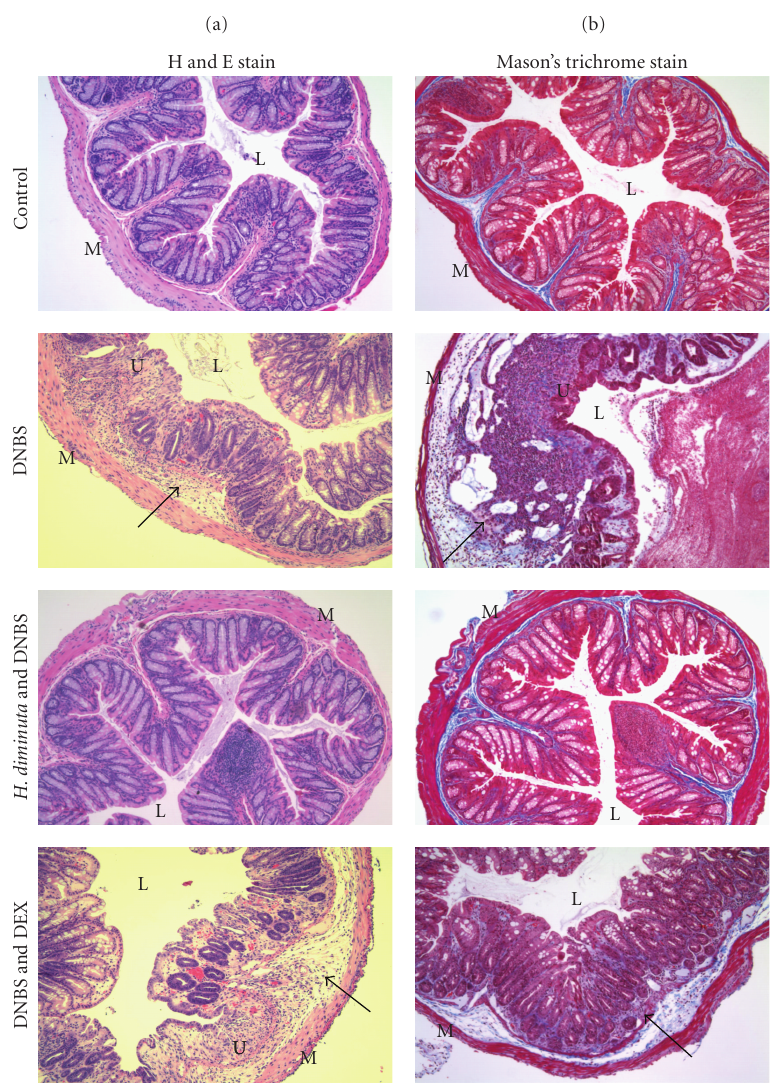
Figure 2: Representative images of gut morphology (hematoxylin and eosin (H&E stain); (a)) and collagen deposition ((b); collagen is stained blue) in colonic sections from the 4 treatment groups (M: muscle; L: gut lumen; U: ulcer; arrow, inflammatory infiltrate: original magnification = ×